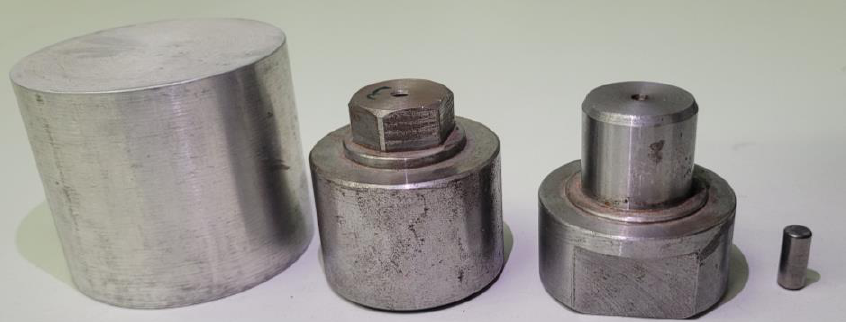
Figure 7. Weights applied for the print-free